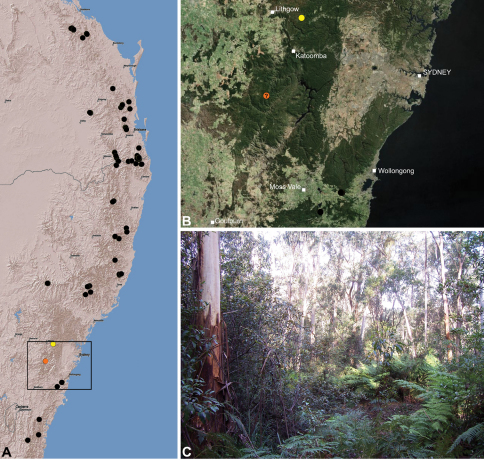
Austrarchaea smithae sp. n., distribution and habitat: A, topographic map showing the known distribution of Archaeidae in south-eastern Queensland and eastern New South Wales, with collection localities for A. smithae highlighted in yellow (orange localities denote genotyped juvenile specimens of tentative identification); B, satellite image showing detail of inset (A); C, wet eucalypt forest at the type locality – Mount Wilson, Blue Mountains National Park, New South Wales (April 2010). Image (C) by M. Rix.